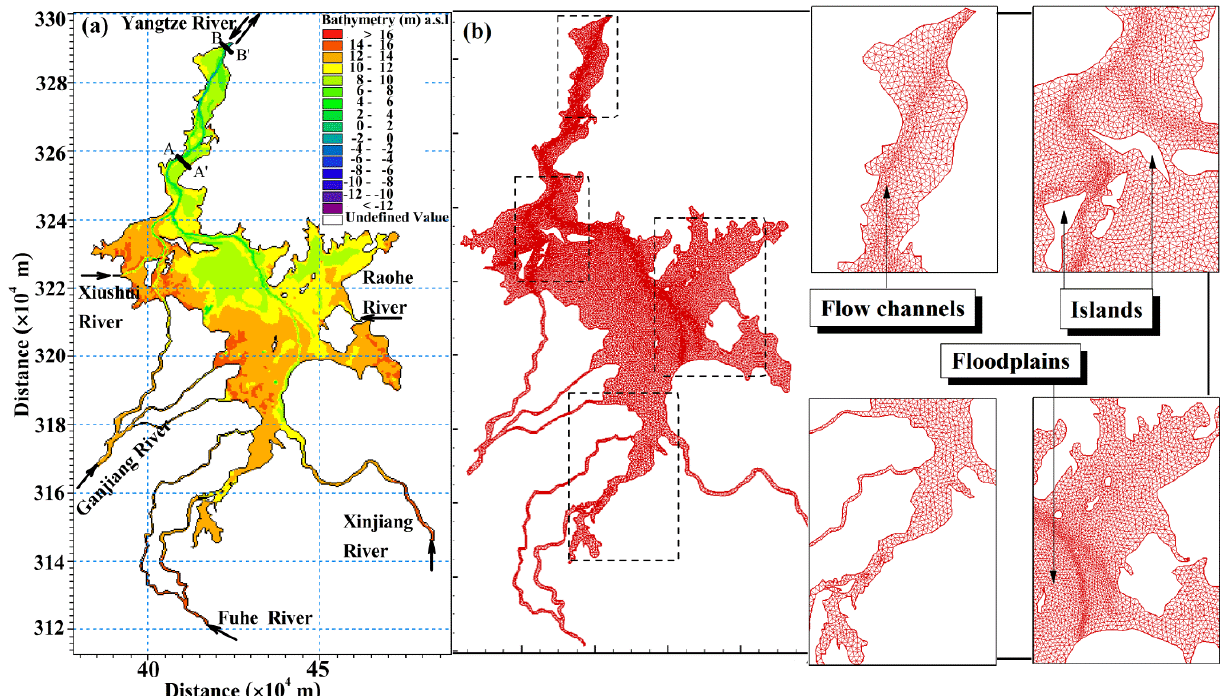
Figure 3. ( a ) Poyang Lake bathymetry, cross-sections of velocity observations (A-A' and B-B') and inflow/outflow sources of the lake (black arrows); ( b ) the unstructured grid for the MIKE 21 model and a close-up of the variable mesh